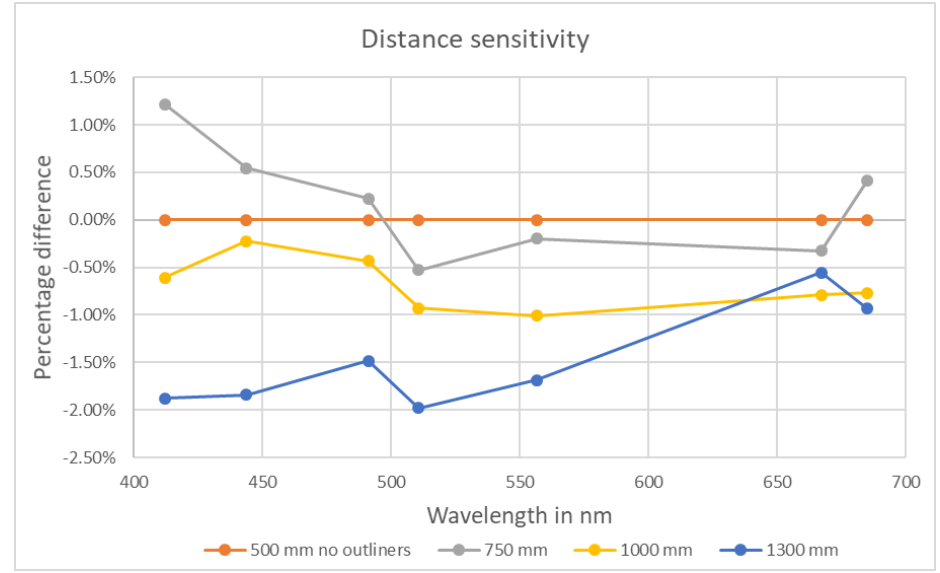
Figure 9. Difference in the radiance calibration coefficient obtained by averaging results from different participants for each lamp-panel